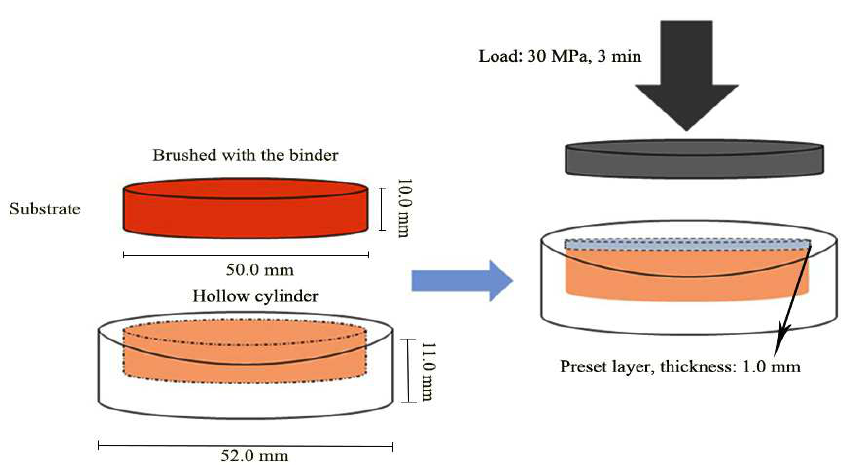
Figure 1. The schematic drawing of the preparation process of the preset